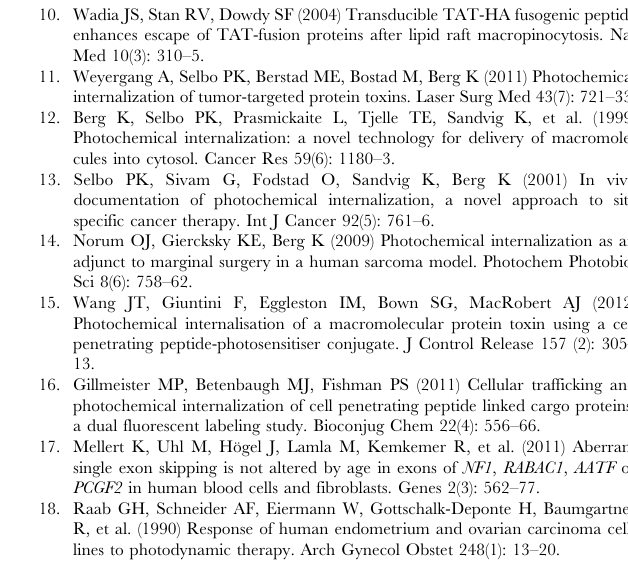
Figure S3 Comparison of transduction rates, cytotoxic- ity and measured levels of transduced proteins using nine different transduction reagents. Whereas the percent- age of transduced cells is quite homogeneous in all transduction protocols (A), the amount of transduced protein (measured by fluorescence intensity) shows striking differences (C) which can not be attributed to the amount of necrotic cells (B) as well. (A) The transduction rates are high in all used transduction protocols. The percentages of transduced cells differ slightly ranging from 89.2% (TurboFect) to 96.8% (Endo-Porter) (n= 20000). (B) Percentage of necrotic cells after transduction measured by propidiumiodide staining. Only 3 transduction reagents (ProJect, TransPassP and TurboFect) induced considerable increases in cell death rates compared to untransduced controls. The relatively high cell death rates of untransduced controls are due to the repeated washing steps previous to the flow cytometer measurements. (C) Fluores- cence intensity of lysed cells per well measured in a multiwell fluorescence reader. The intensities were normalized to the mean intensity produced by the transduction using Proteoducin as transduction reagent. Error bars represent the 95% confidence interval of the means. Each transduction reagent was tested in at least 6 independent experiments. Figure S4 Transduction of Atto488-BSA using different transduction reagents. All reagents produced punctual Atto488 signals within the sarcoma cells which were often located close to the nucleus. Only in cells transduced by Endo-Porter, a low level homogeneous fluorescence signal throughout the cell was detectable, suggesting cytosolic localisation of Atto488-BSA. Scale bars represent 10 m m. Figure S5 Intracellular localisation of the internalized Atto488-BSA. Proteoducin Atto488-BSA transduced sarcoma cells were recorded by confocal laserscanning microscopy (0.9 m m layer) confirming that the signals were inside the cells. Shown is